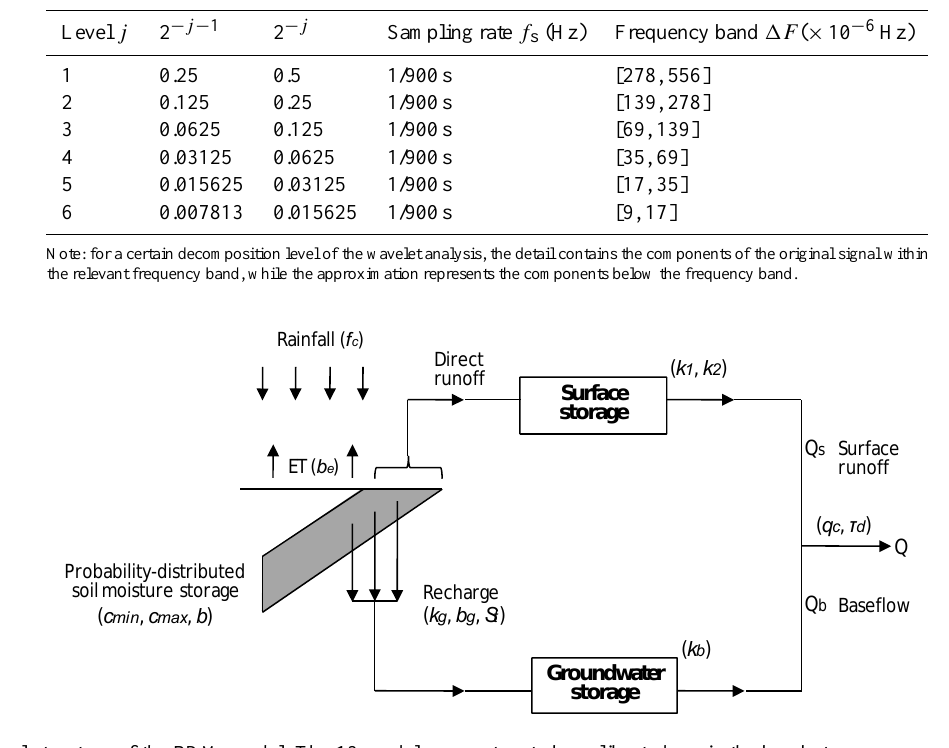
Figure 3 Conceptual structure of the PDM model. The 13 model parameters to be calibrated are in the